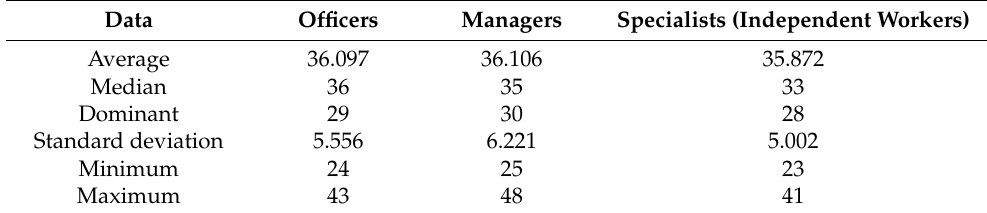
Table 1. Age of the respondents—descriptive statistic. Source: own research.